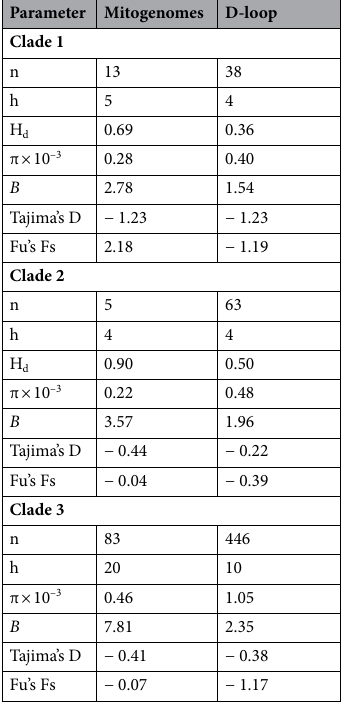
Table 2. Summary statistics of the genetic diversity in three lineages of wild boar in Central and Eastern Europe, based on full mitogenome and D-loop (control region) sequences; n —number of individuals,